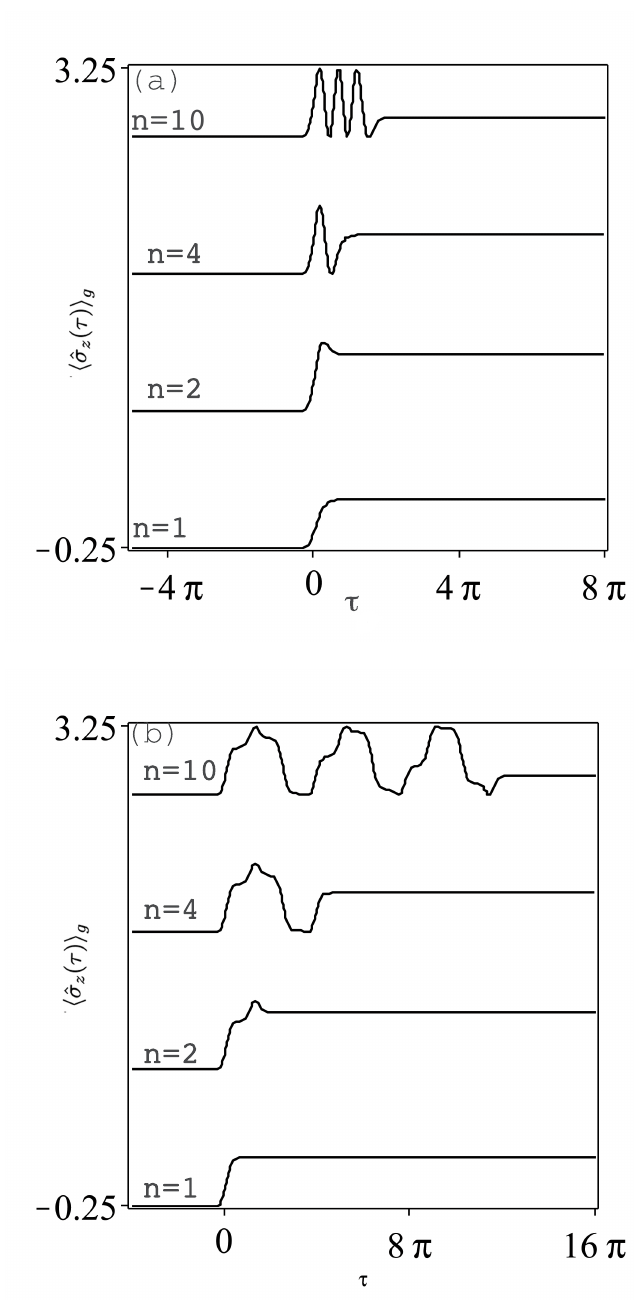
Figure 3. ( a ) Plot of (cid:104) ˆ σ z ( τ ) (cid:105) g , with Ω 1 = 1, τ R = 0.5 for different pulse number. ( b ) As ( a ) but for τ R =